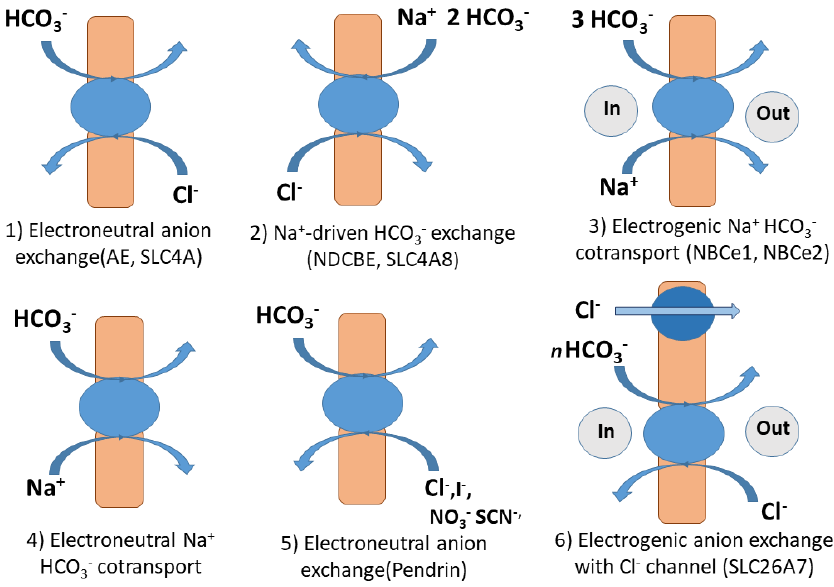
Figure 1. Mechanisms of HCO 3 − transport by solute carriers (SLC) in humans and mammals drawn with information from [37,40].